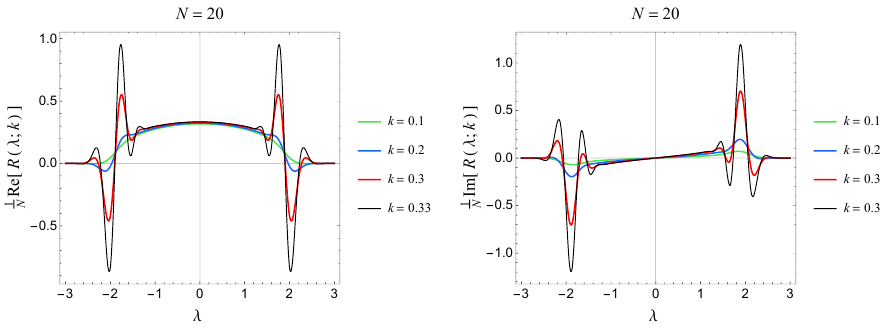
Figure 5 . The real (left) and imaginary (right) part of the quenched spectral density for N = 20.